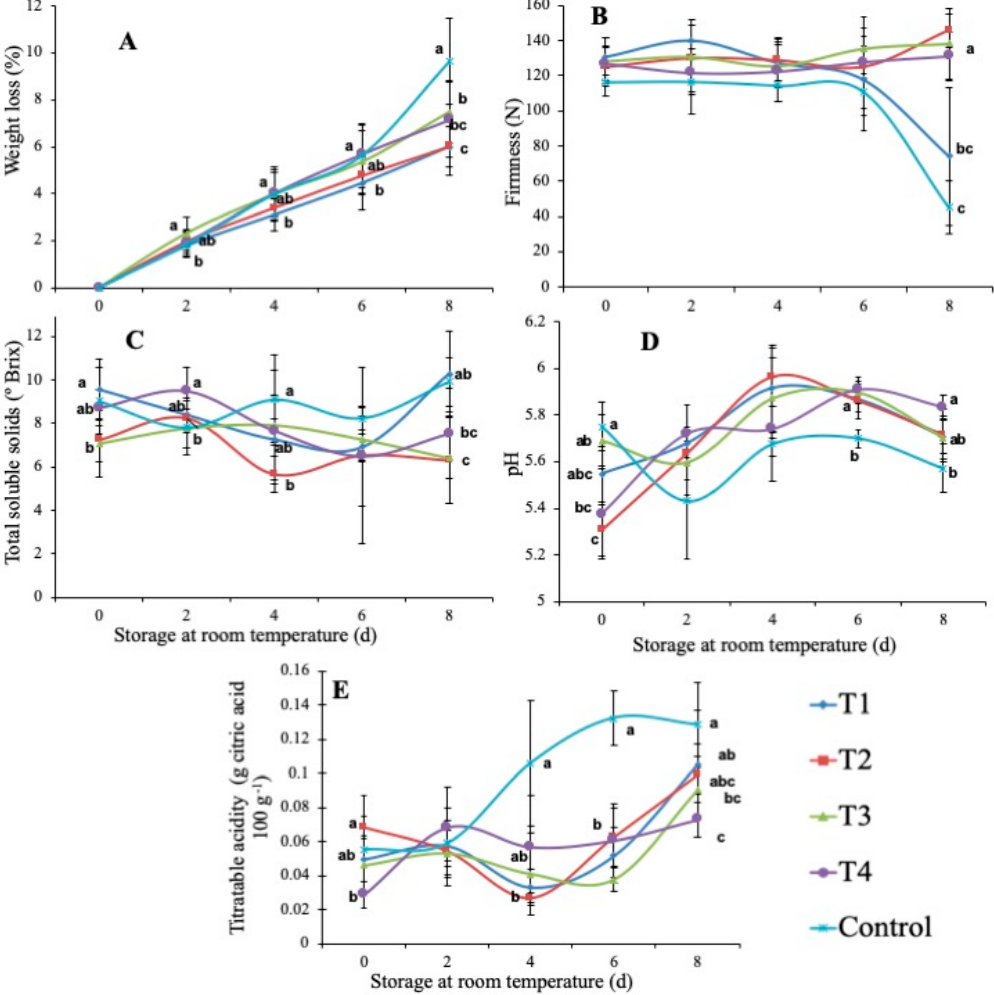
Figure 1. Weight loss ( A ), firmness ( B ), total soluble solids ( C ), pH ( D ), and titratable acidity ( E ) of ‘Maradol’ papaya fruits from plants grown under different production schemes and stored at 30 ± 2 °C and 80% RH. Different letters (per day) denoted significantly differences ( p < 0.05). For treatment details, see Table 1.